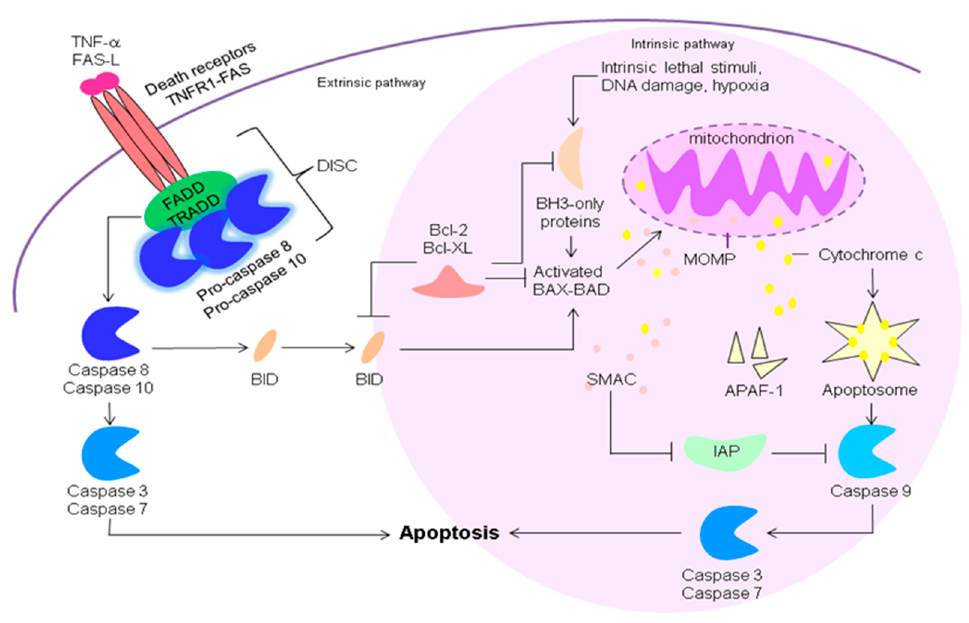
Figure 2. Extrinsic and intrinsic apoptotic pathway. The intrinsic pathway is mediated by intracellular signals of cell stress leading to an increase in the BH3 only proteins (members of the B-cell lymphoma 2 (Bcl-2) family) resulting in an inhibition of the protectors and activation of the e ff ectors. The e ff ectors Bax and Bad increase the permeability of the mitochondrial membrane (MOMP: mitochondrial outer membrane permeabilisation) resulting in leakage of apoptotic proteins. One of these proteins, known as second mitochondria-derived activator of caspases (SMAC), binds to proteins that inhibit apoptosis (IAPs, by suppression of the caspase proteins) causing an inactivation of these IAPs. Another protein released from the mitochondria is cytochrome c, which binds to Apoptotic protease activating factor-1 (Apaf-1) and ATP. This complex binds to procaspase-9 creating a complex, the apoptosome. The apoptosome cleaves procaspase-9 to its active form of caspase-9, which in turn is able to activate the e ff ector caspase-3. The extrinsic pathway is mediated through receptors of the tumor necrosis factor (TNF) receptor (TNFR) family either via the TNF path or the Fas (first apoptosis signal) path. In the TNF path binding of TNF- α to a trimeric complex of TNFR1 molecules induces activation of the intracellular death domain and the formation of the receptor-bound complex 1 made up of TNF receptor-associated death domain (TRADD), receptor-interacting protein kinase 1 (RIPK1), two ubiquitin ligases (TNFR-associated factor (TRAF)-2 and cellular inhibitors of apoptosis (clAP)1 / 2) and the linear ubiquitin assembly complex (LUBAC). This complex 1 can lead to a pro-survival pathway or to apoptosis. In case of apoptosis the TRADD dependant complex IIa (consisting of TRADD, Fas-associated death domain protein (FADD) and caspase-8) or the RIPK-1 dependant complex IIb also known as the ripoptosome (consisting FADD, RIPK1, RIPK3 and caspase-8) is formed. In the Fas path, presence of the Fas ligand (FasL, expressed on cytotoxic T lymphocytes) causes three Fas receptors (CD95) to trimirize. This clustering and binding to the FasL initiates binding of FADD. Three procaspase-8 or -10 molecules can then interact with the complex by their own death e ff ector domains. The complex formed is the death-inducing signalling complex (DISC) which cleaves and activates procaspase-8 and 10. Activation of the initiator caspase-8 by both paths directly activates other members of the caspase signalling cascade such as the e ff ector caspase-3 but also can lead to an increase in BH3-only proteins (Bim, Bid) and trigger the intrinsic